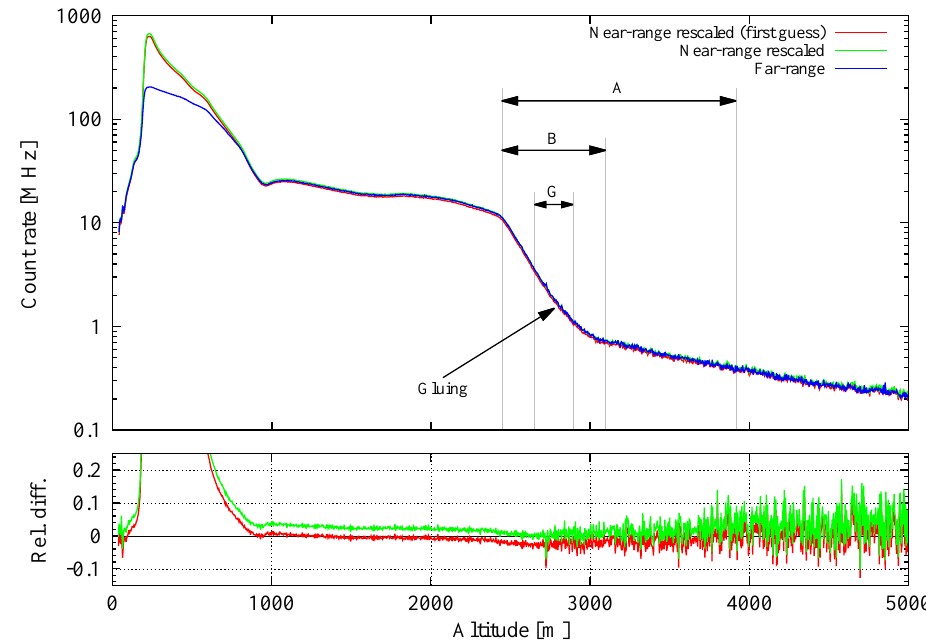
Figure 4. Example of the results of the automatic gluing algorithm shown in Fig. 3. The algorithm is applied to the analog (near range) and photon-counting (far range) elastic cross signals measured at 532nm by the MUSA lidar of the Potenza station. In blue is shown the photon-counting signal, in red the near-range signal normalized to the photon-counting signal in region A , i.e. the first guess of the gluing region, and in green the near-range signal normalized in region G , i.e. the final optimal gluing region. Region B represents the gluing region obtained after the slope test shown in Fig. 3 and discussed in the text. “Gluing” marks the point at which the blue and green signals are glued. In the bottom plot the relative differences of the two rescaled analog signals with respect to the photon-counting profile are